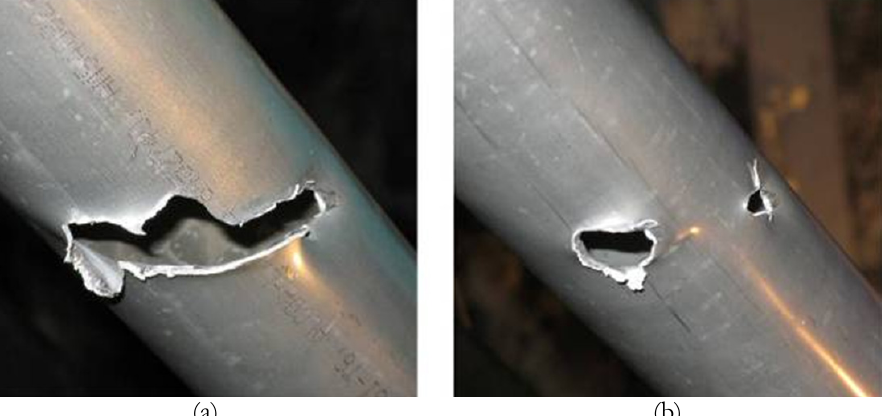
Figura 7: Principali tipologie di danno balistico osservate al termine dei test: a) singolo foro; b) doppio